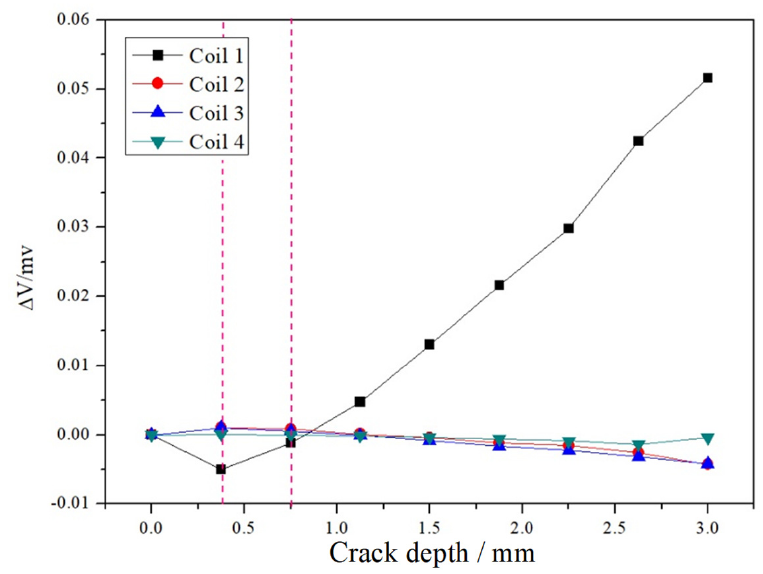
Figure 3. The change of induced voltage of sensing coils versus the crack propagation.